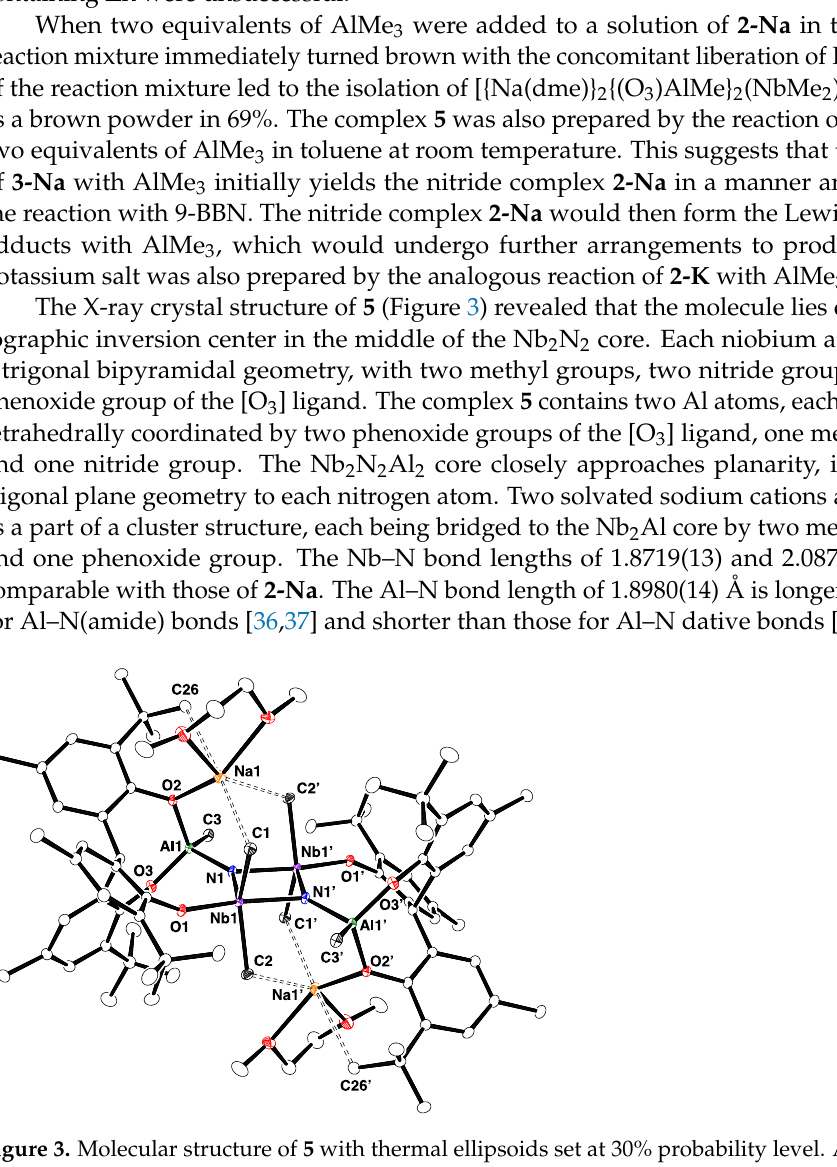
Figure 3. Molecular structure of 5 with thermal ellipsoids set at 30% probability level. All hydrogen atoms and methyl groups of para - tert -butyl substitutes of aryloxide are omitted for clarity.